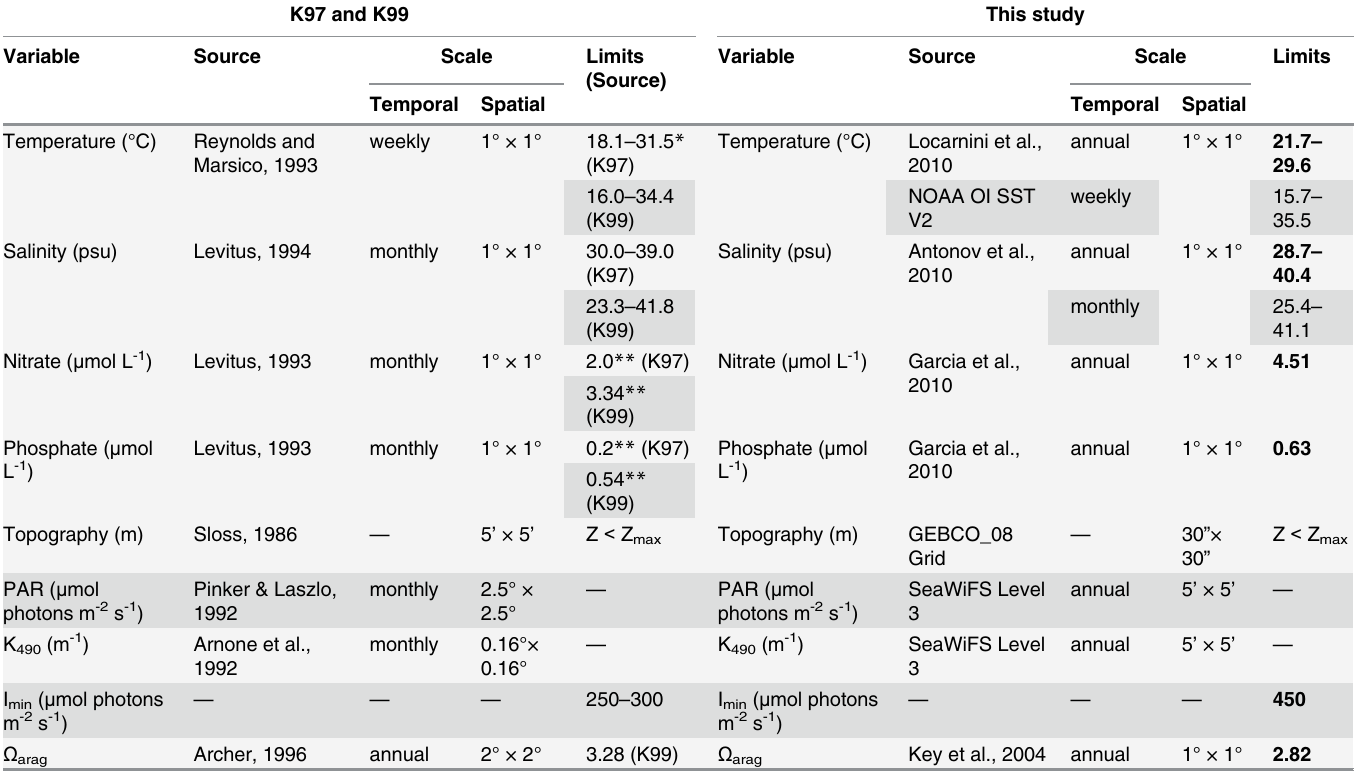
Table 1. Tolerance limits for coral reefs associated to environmental